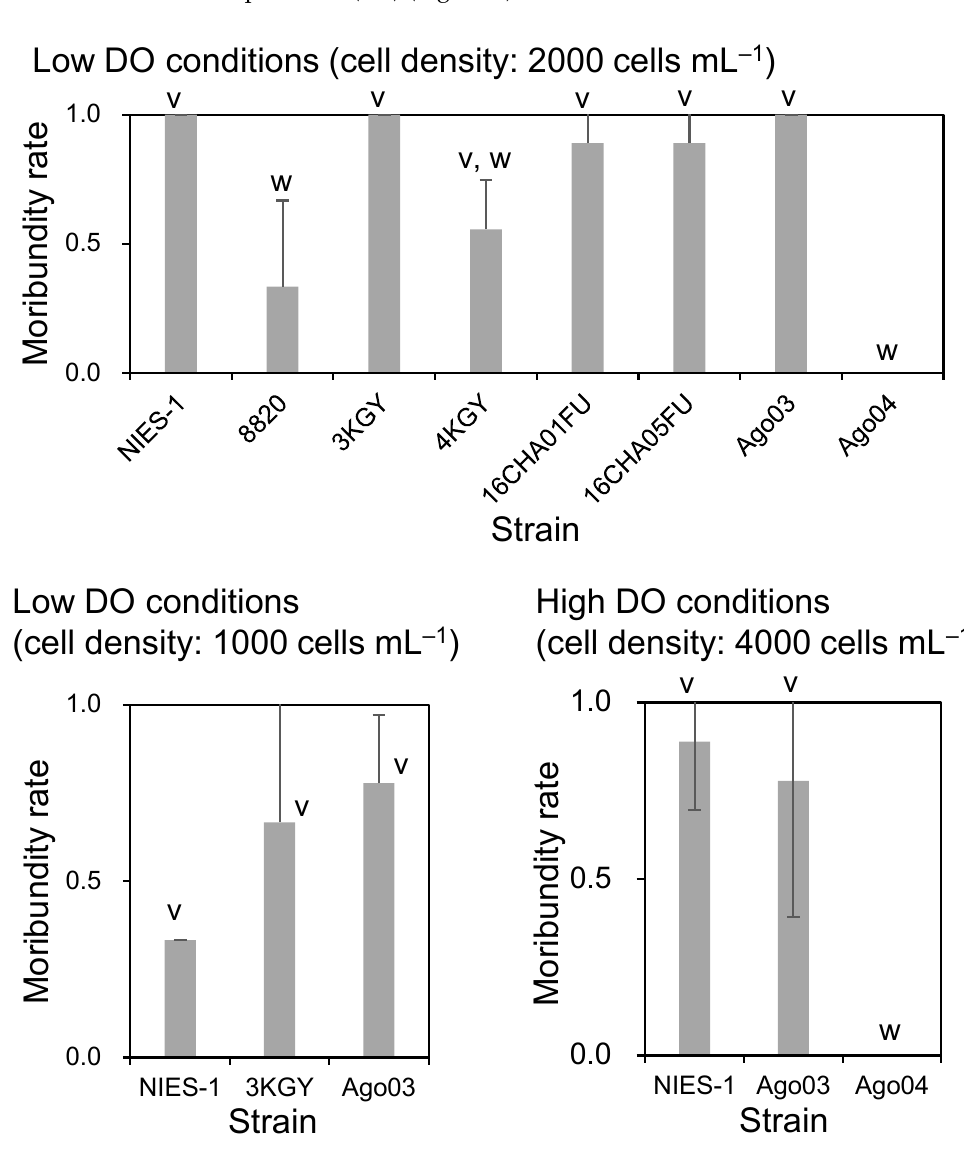
Figure 2. Toxicity of Chattonella strains to red seabream under different dissolved oxygen concentra- tions and exposure cell densities. Each bar represents the mean ± SD of triplicate measurements. Means that are not significantly different are labeled with the same letter (v or w; p < 0.05). When yellowtails (TL, 8.2 ± 1.7 cm; BW, 6.1 ± 4.0 g) were exposed to dense cultures (around 6000 cells mL − 1 ) of strains showing low or intermediate toxicity to red sea breams, some (strains 8820 and 4KGY) or all (Ago04) fish remained normal until the end of the experiment (8 h). There were significant differences between the moribundity rates of yellowtails exposed to strain 8820 or 4KGY and strain Ago04 (Figure 3). For the strains highly toxic to red sea breams (NIES-1, 3KGY, and Ago03), yellowtails were exposed